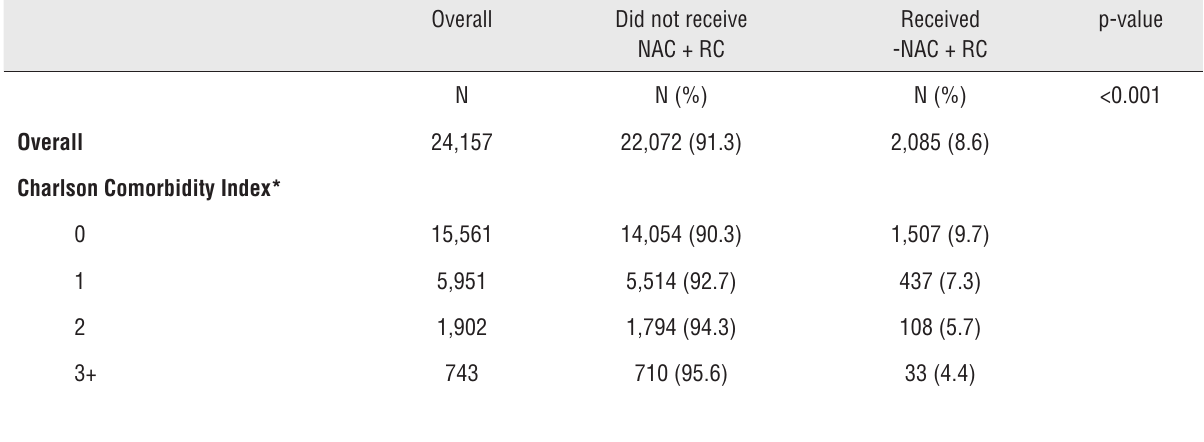
Table 4a - Rates NACRC for patients with MIBC by Charlson Comorbidity Index score 2006-2015. Overall